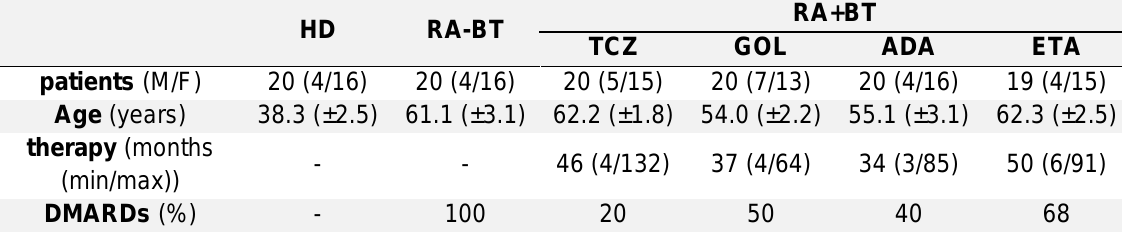
Table 1: Baseline characteristics of patients and healthy